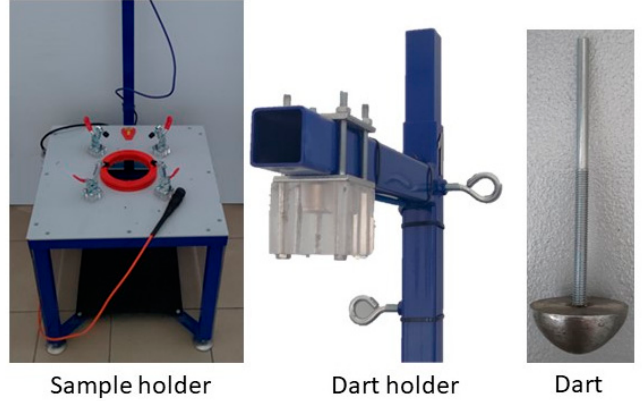
Figure 2. Original research stands of impact resistance by the free-falling dart determination.